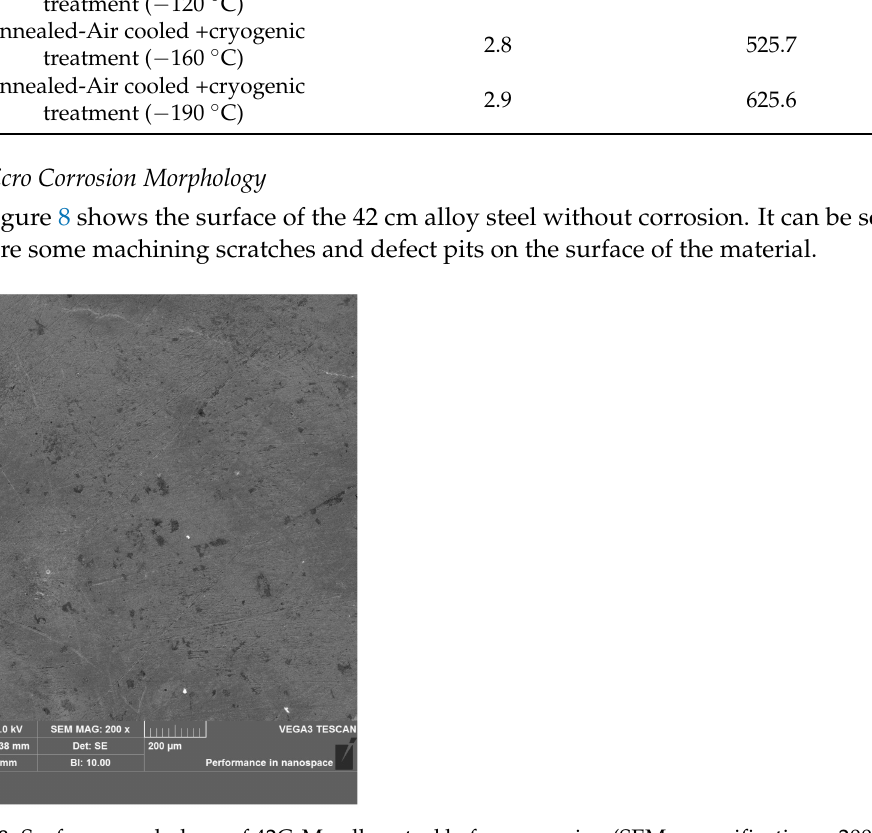
Figure 8. Surface morphology of 42CrMo alloy steel before corrosion (SEM, magnification ×